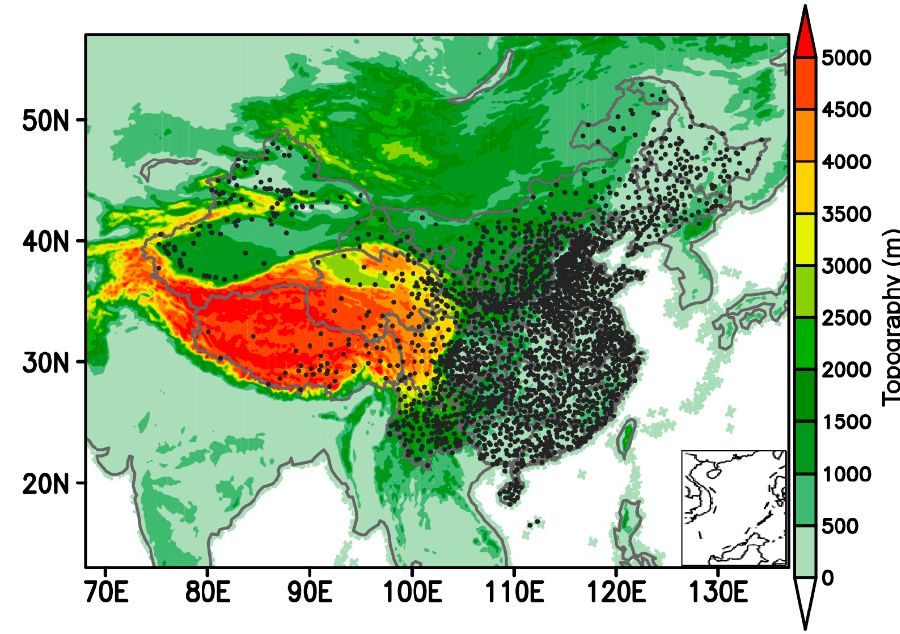
Figure 1. Distribution of 2380 national surface stations (black dots) of China, which provide the observation used for the example verification of the ensemble forecasting. The shaded is topographic height in meter.